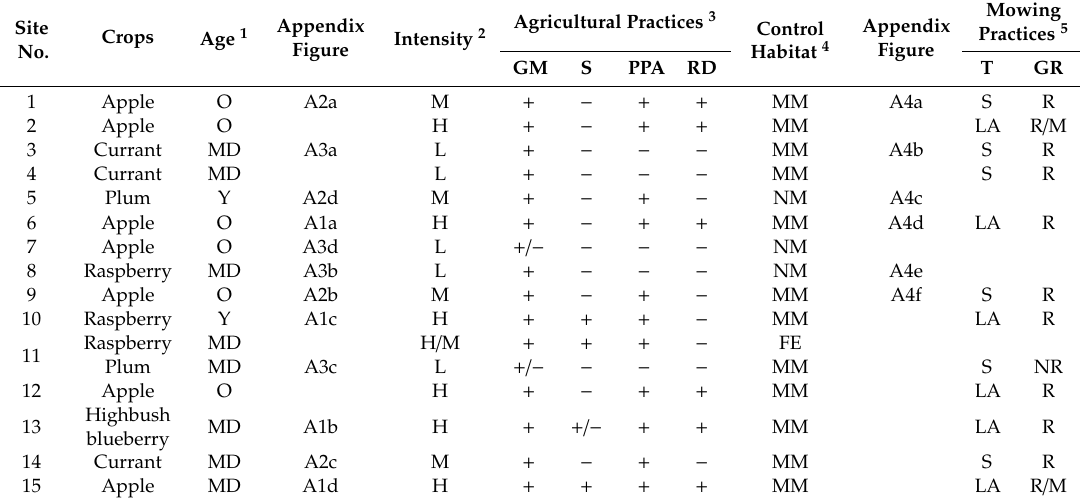
Table 1. Characteristics of study sites. Site numbers as in Figure